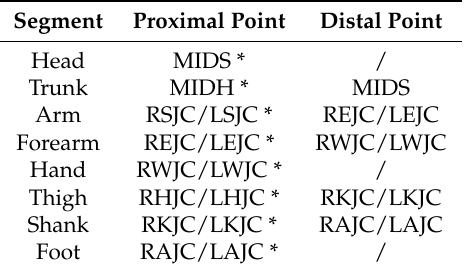
upward (vertically), and the y -axis completes the